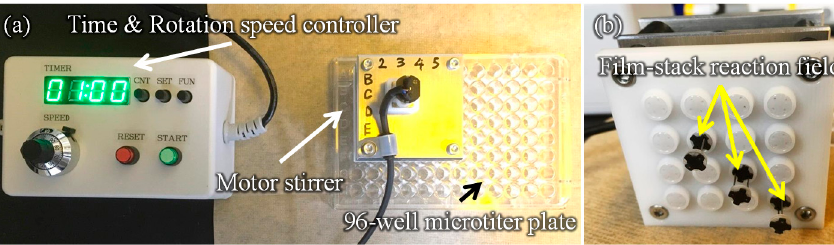
Figure 4. Images of the developed motor stirrer. ( a ) Whole image. ( b ) Bottom view of the rotated part in the motor stirrer. In the ELISA procedure, film-stack reaction fields are put on the bottom of the rotated part in the motor stirrer and this stirrer is set up on a 96-well microtiter plate to place reaction fields in wells.